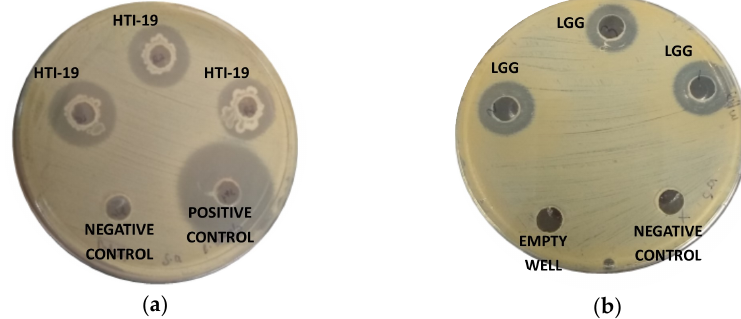
Figure 3. Inhibition zone of ( a ) potential probiotic B. amyloliquefaciens HTI-19 (HTI-19) against